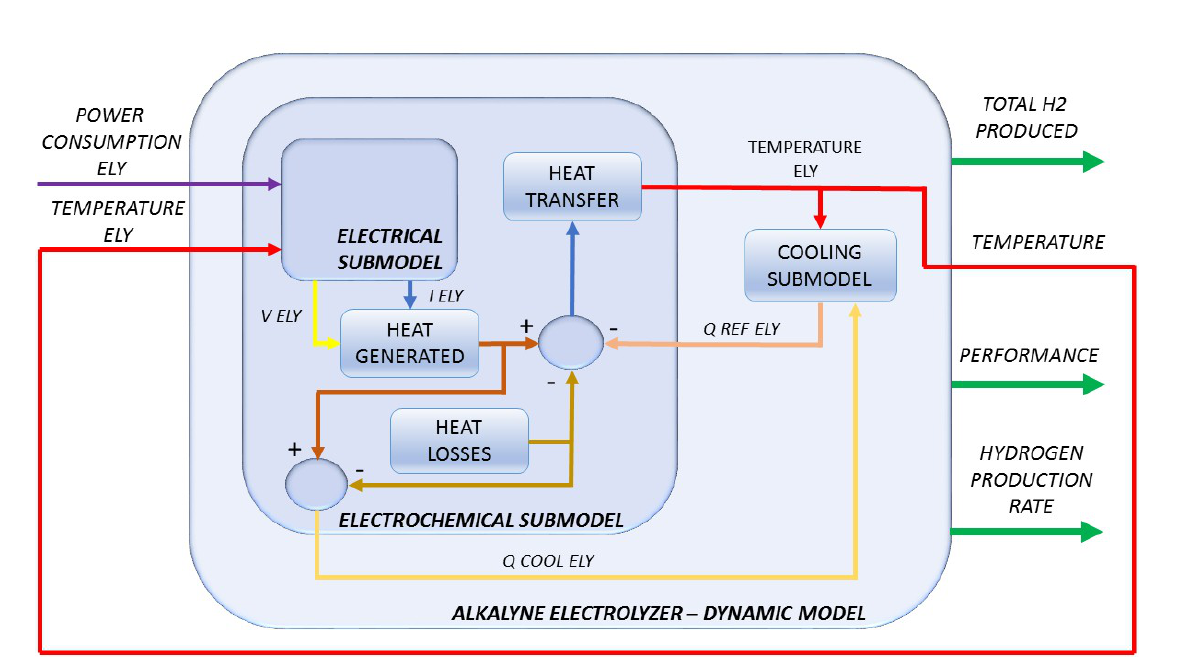
Figure 3. Block diagram of sub-models for an advanced alkaline